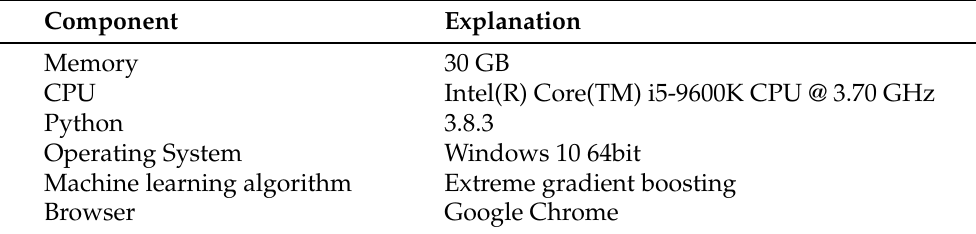
Table 5. Development environment of the proposed